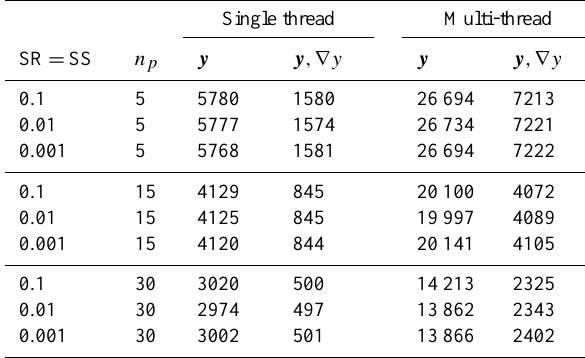
Table 2. Benchmark results of the fast forward operator on an Intel i7-3770 with respect to the number of used principal components n p , spectral resolution SR, spectral sampling SS, and for the pure interpolation result y and the interpolation result and correspond- ing Jacobian y , ∇ y . Spectral resolution and spectral sampling were chosen to be the same per run and carry the unit of nm. The unit for the benchmark results is simulated spectra per second. Eight threads were used for the multithread run. Single